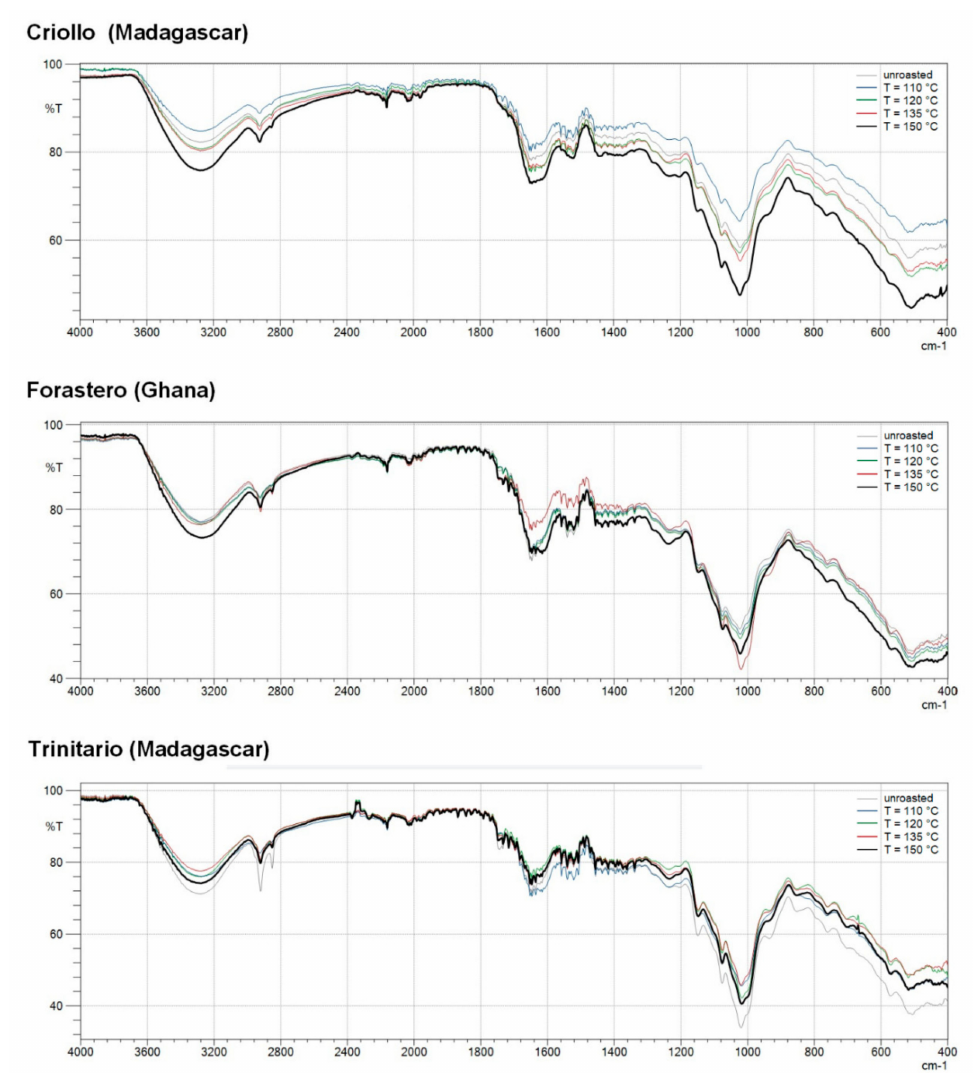
Figure 4. Fourier transform infrared spectroscopy (FTIR) spectra of HMW fractions isolated from raw and roasted, at di ff erent at di ff erent temperatures and relative air humidities, cocoa beans of di ff erent